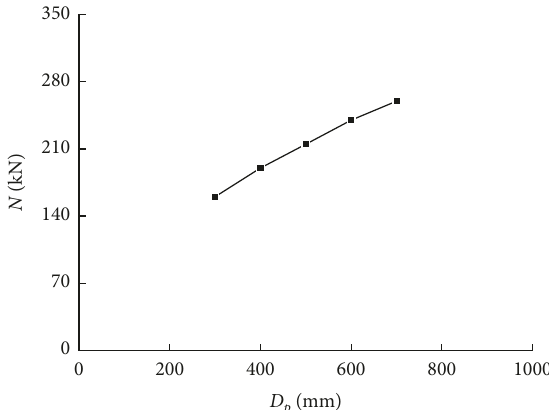
Figure 10: Influence of anchor plate burial depth.